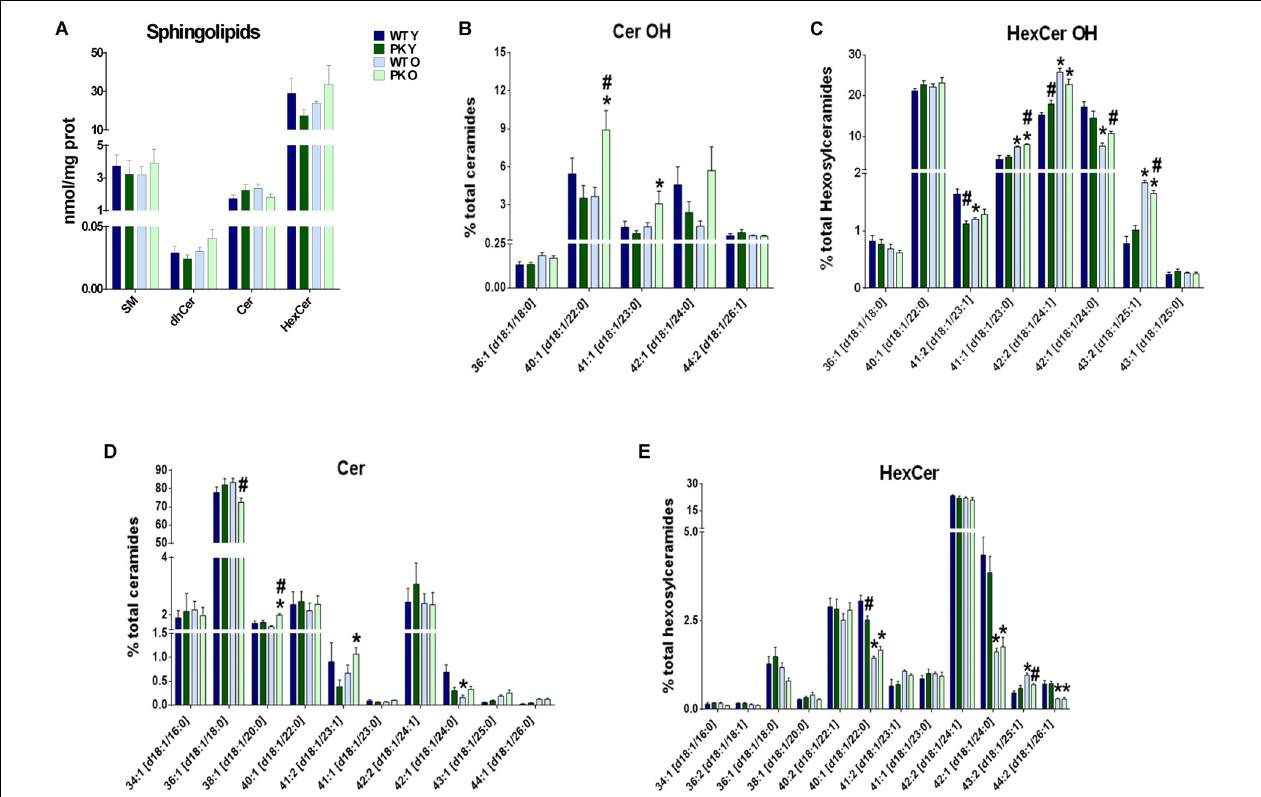
FIGURE 4 | Sphingolipids content in PK-KO mice’s brain mitochondria. PK-KO mice’s mitochondria have higher levels of hydroxylated ceramides due to aging. (A) Levels of different classes of sphingolipids (SM, dhCer, Cer, and HexCer) and changes due to aging and parkin loss. (B) Percentage of Hydroxylated ceramide species. (C) Percentage of Hydroxylated Hexosyl Ceramide species. (D) Percentage of ceramide species. (E) Percentage of HexCer species. For panels B–D data are expressed as percentage of each lipid specie levels versus total levels of the lipid class analyzed. Graphs represent the mean ± SEM. Statistical analysis was performed by One Way ANOVA test. ∗ p < 0.05 due to aging. # p < 0.05 due to Parkin